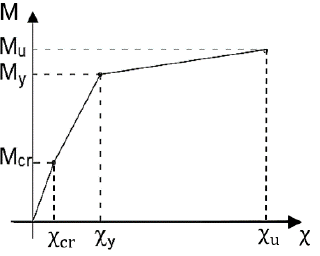
Figure 1. Ideal bending-moment curvature diagram.